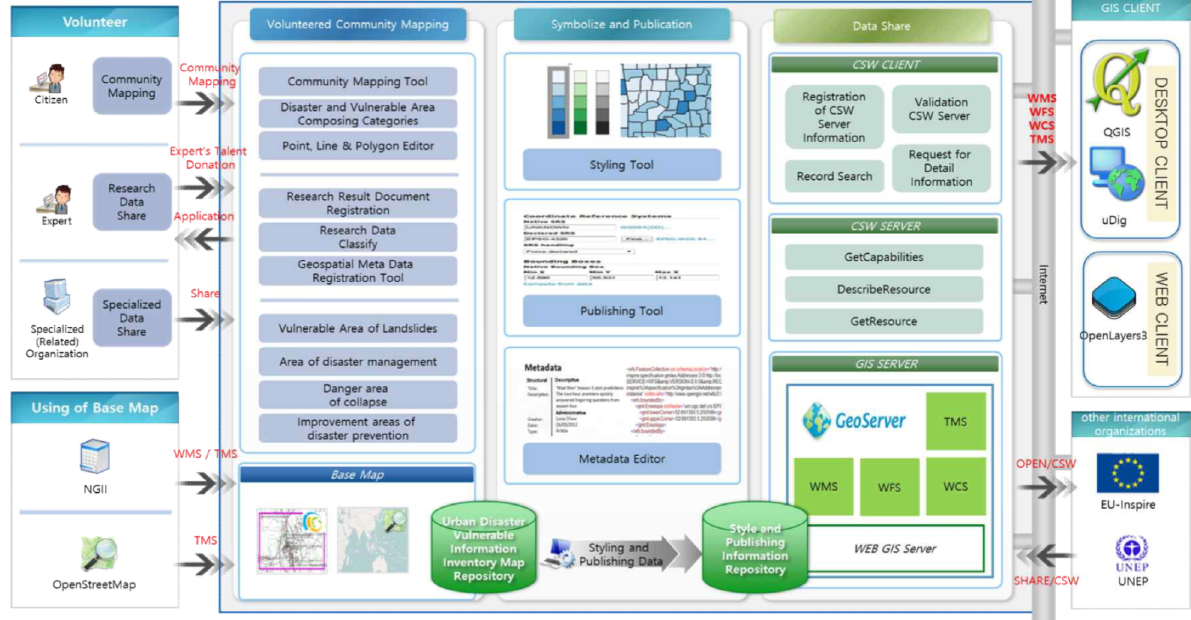
Figure 1. System structure for VGI-GeoPortal for Disaster